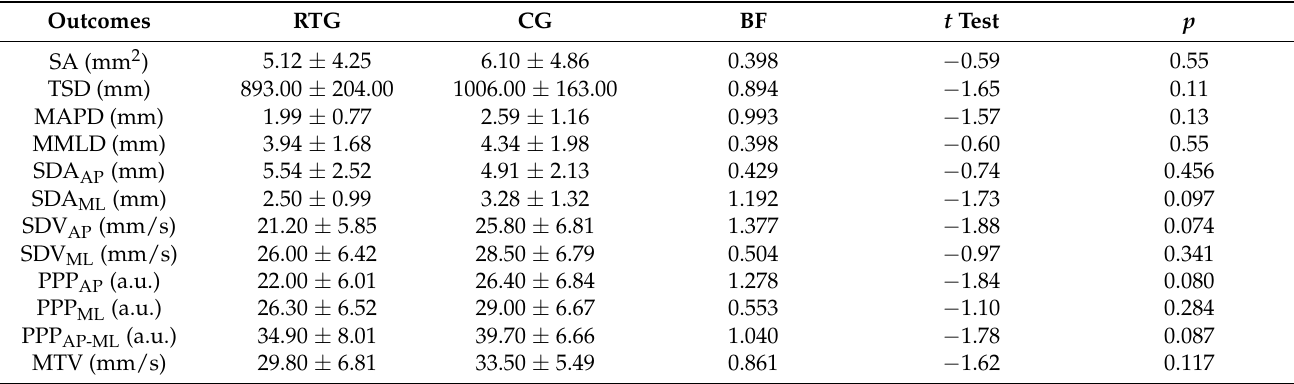
Table 4. Group comparisons in eyes-open balance test after intervention.